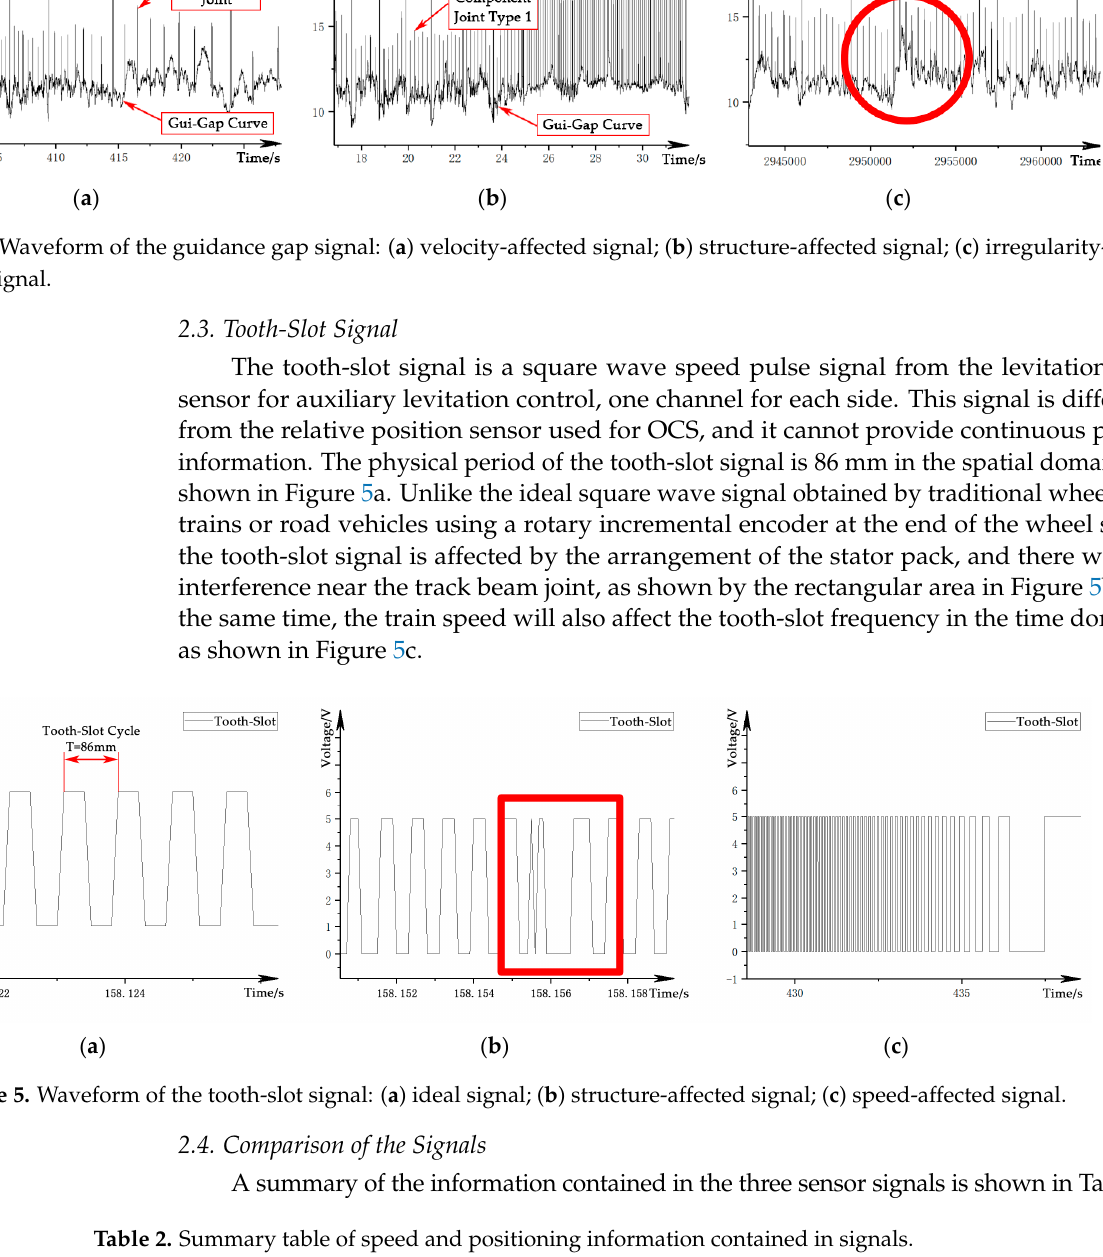
( c ) Figure 3. Waveform of the levitation gap signal: ( a ) ideal signal; ( b ) structure-affected signal; ( c ) velocity-affected signal. 2.2. Guidance Gap Signal The guidance gap signal is a signal that characterizes the distance between the